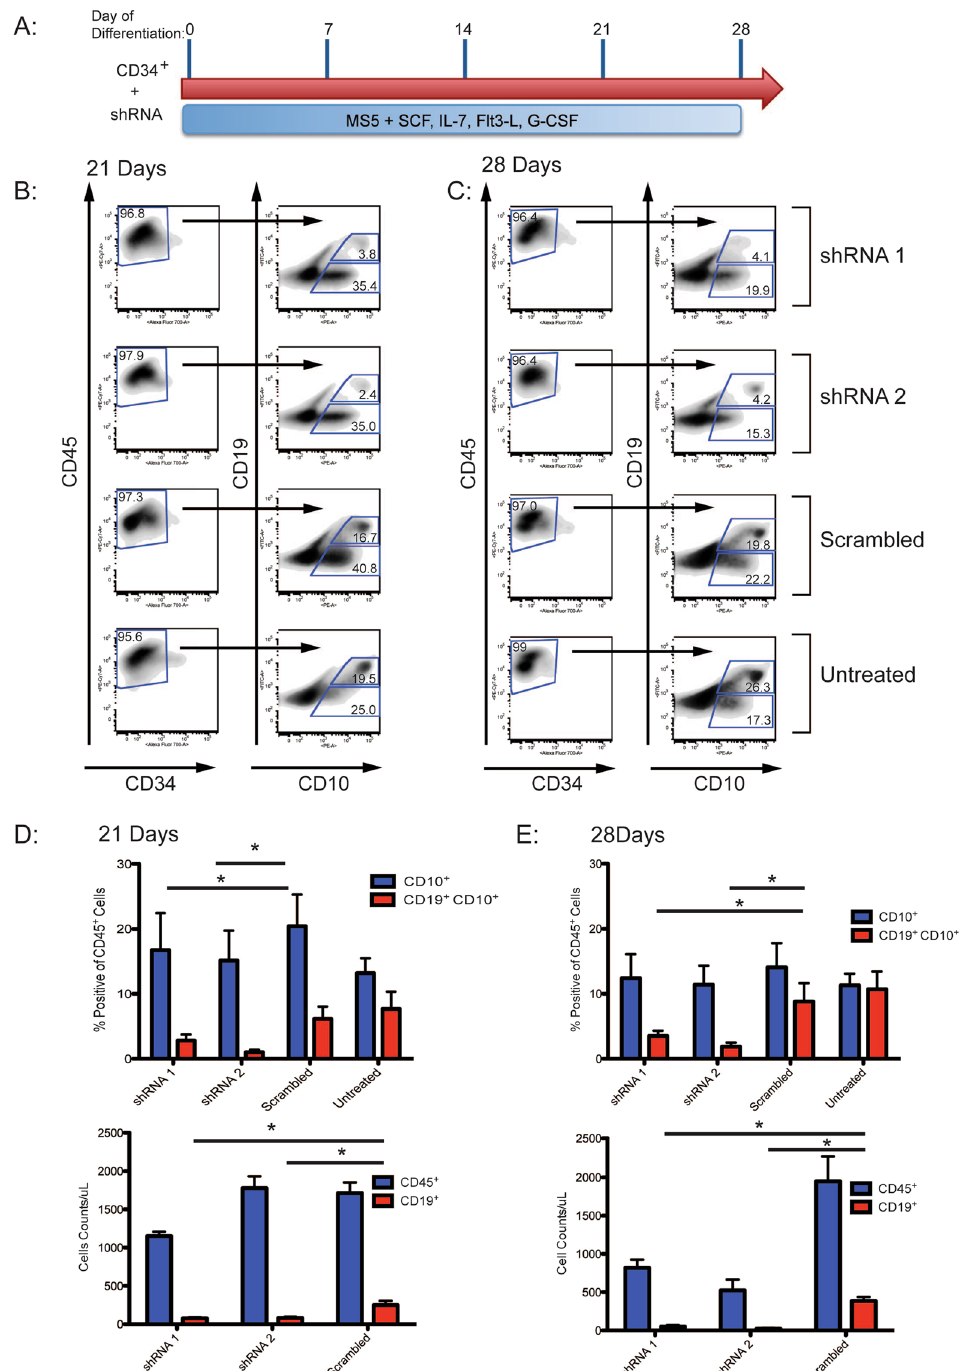
Figure 4. shRNA Knockdown of EDNRB in CB CD34 + cells Reduces Efficiency and Absolute Output of B Cell Differentiation. ( A ) Differentiation conditions for transduced CB CD34 + cells. ( B , C ) Representative FACS analysis of CB CD34 + cells after 21 or 28 days of differentiation. The first column of panels depicts CD45 + and CD34 + staining, and the second column shows CD19 + and CD10 + staining within the CD45 + CD34 − population. Each row shows cells transduced with specific EDNRB shRNA, a scrambled control, or untransduced cells. ( D , E ) Quantification of FACS analysis showing percentage of CD10 + and CD19 + CD10 + within the CD45 + CD34 − population for various experimental groups after 21 and 28 days of differentiation. Also represented are the cell counts for generated CD45 + and CD19 + cells as determined using CountBright beads. ( * p-value ≤